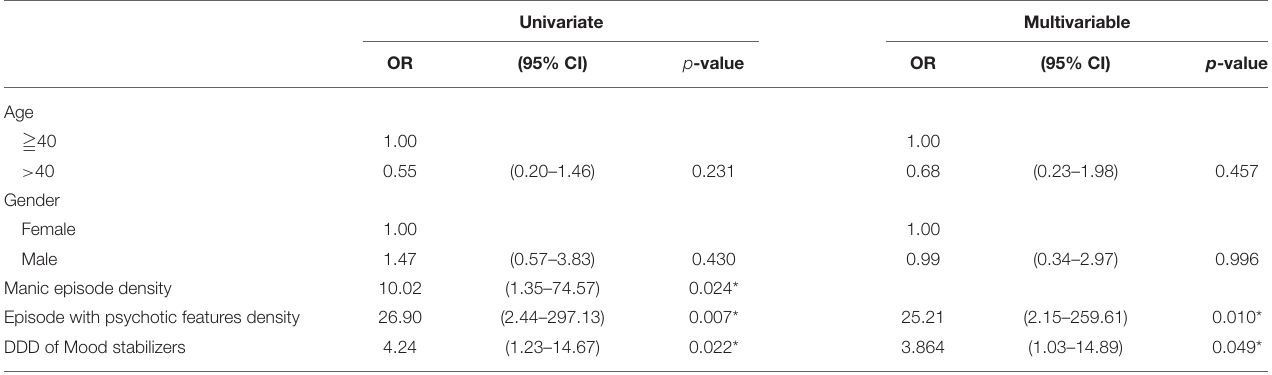
TABLE 3 | Risk factors for cognitive decline in BD using univariate and multiple logistic regression analyses. Univariate Multivariable